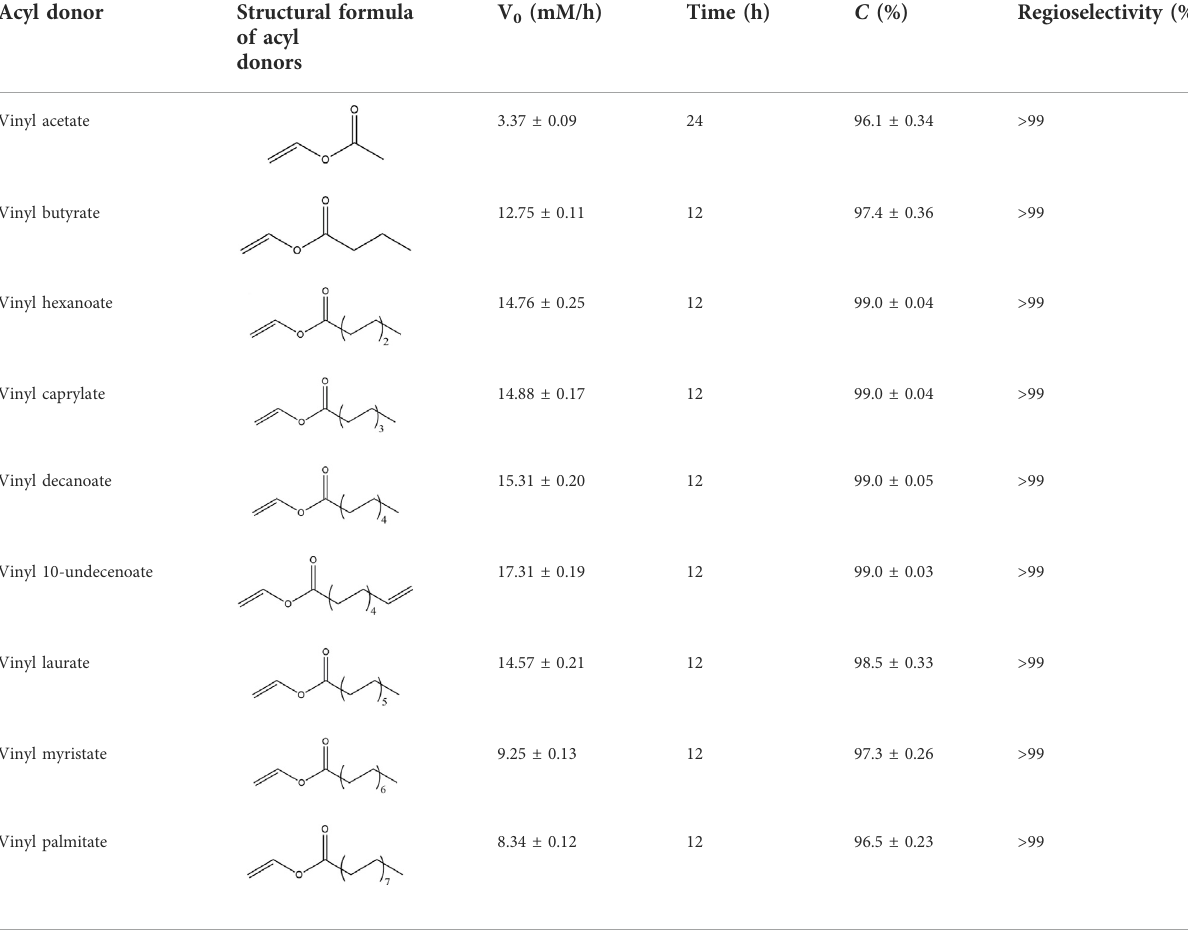
TABLE 3 Effect of various acyl donors on regioselective acylation of salidroside catalyzed by Aspergillus oryzae